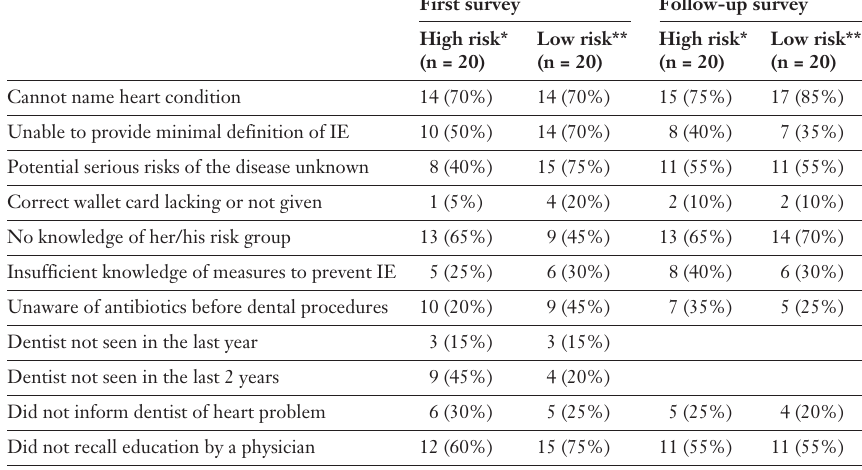
Table 5 Comparison first survey and follow-up in selected